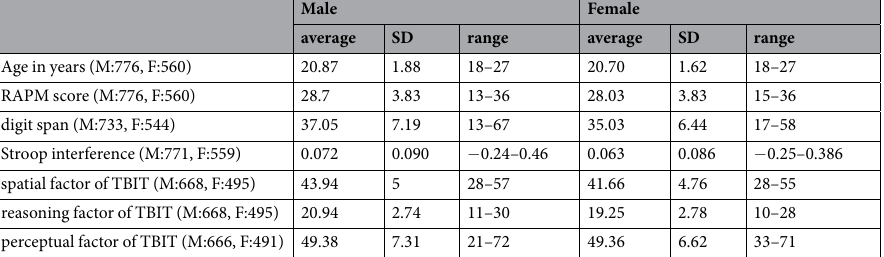
Table 1. Average, SD, and range of cognitive test scores and ages of males and females in our sample. RAPM, Raven’s Advanced Progressive Matrix; TBIT, Tanaka B-type intelligence test.